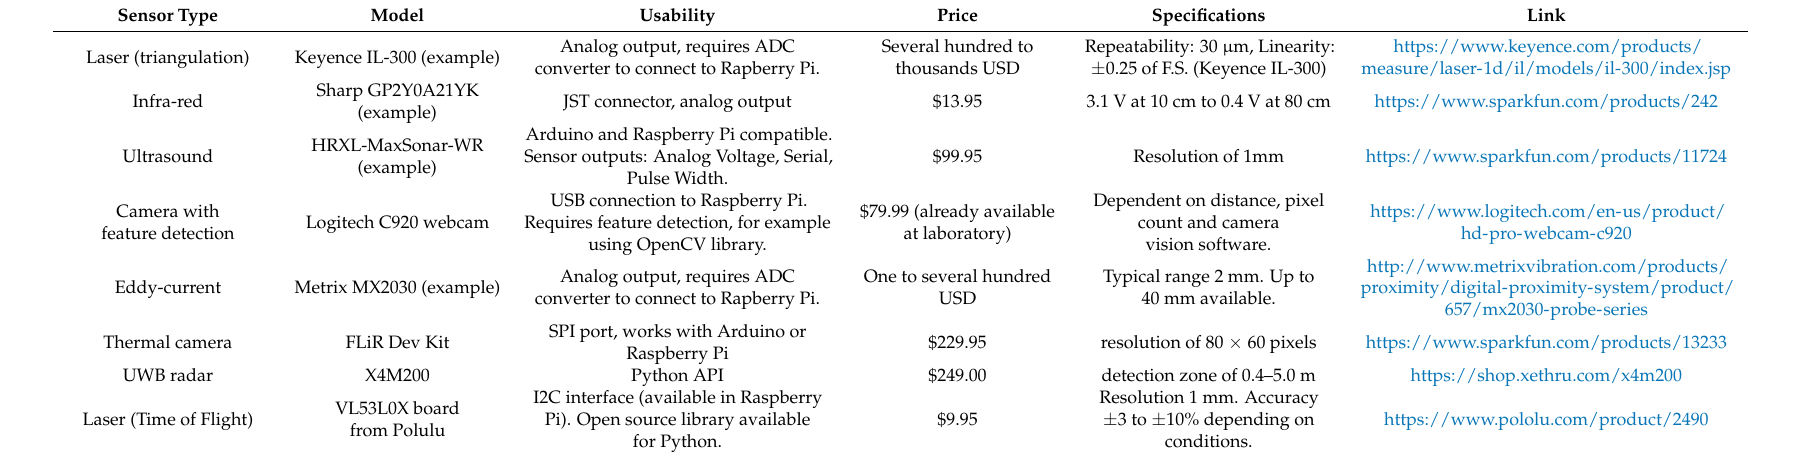
Table 2. Review of possible sensors as result of Probe